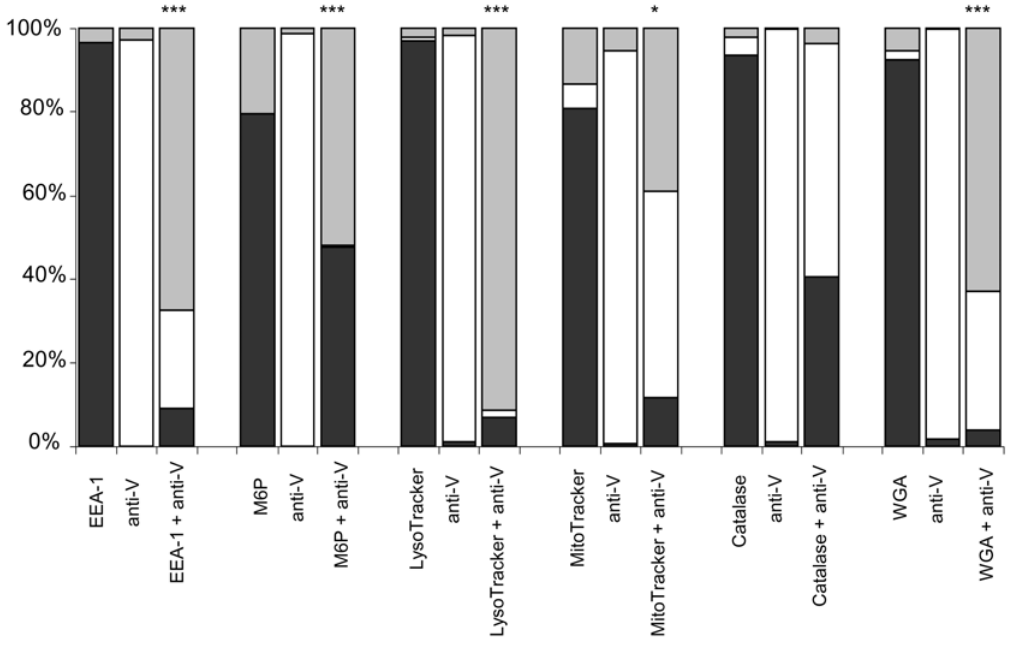
Figure 5. Region statistics of flow cytometry data. Percentages of flow cytometry fluorescence detected in the FL-1 only (region 1), FL-2 only (region 2), or both (region 3) channels, which included infected organelles stained with organelle-associated markers alone, anti-V alone, or both, were plotted. Post ANOVA t-tested indicated significant increases in the percentage of those isolated organelles that demonstrated both organelle and anti-V Ab staining in region 3 as compared to anti-V Ab staining alone, as observed in those organelles stained with both anti-V Ab and EEA-1 Ab (***, P , 0.001), LysoTracker (P , 0.001), MitoTracker (*, P , 0.05), or WGA (P , 0.001), suggesting co-localization. No significant increase in a double- stained population was observed when isolated organelles were stained with both catalase and anti-V